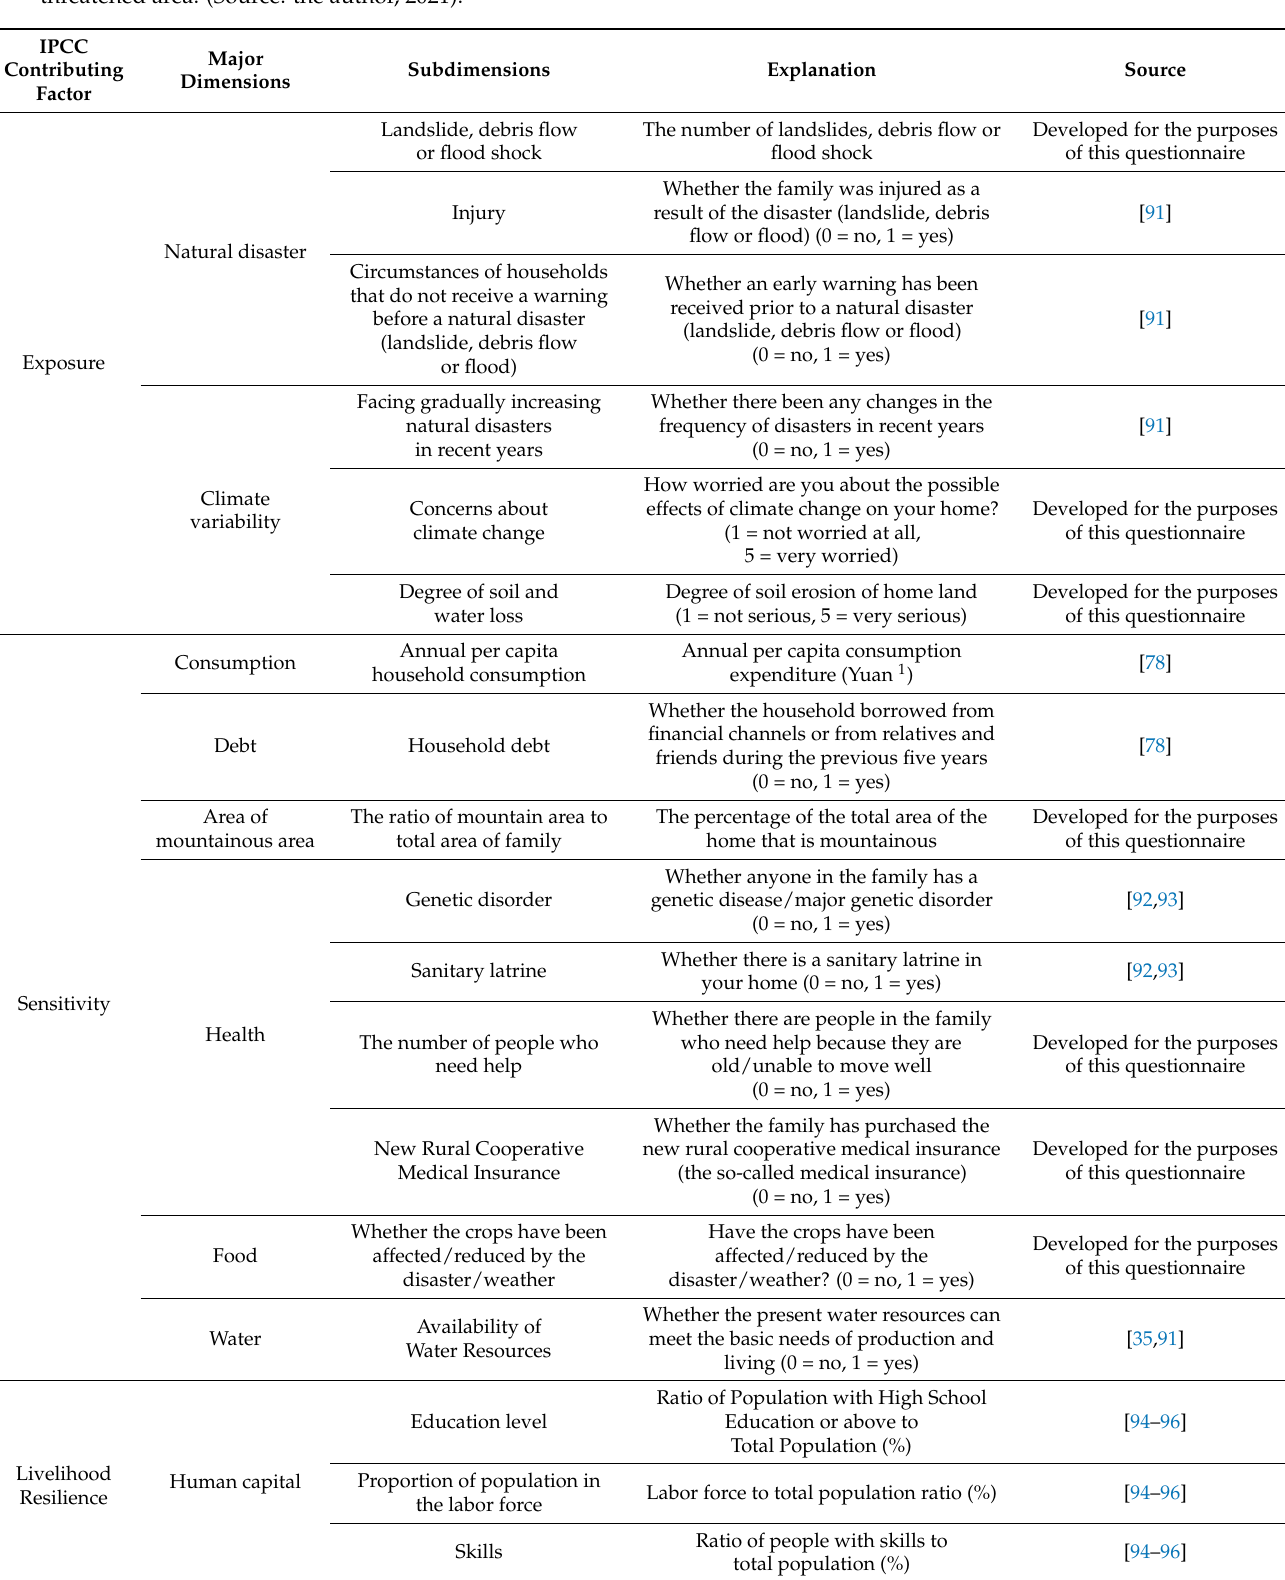
Table 1. Major dimensions and subdimensions comprising the IPCC-LVI developed for flood- and geological hazard-flow- threatened area. (Source: the author,